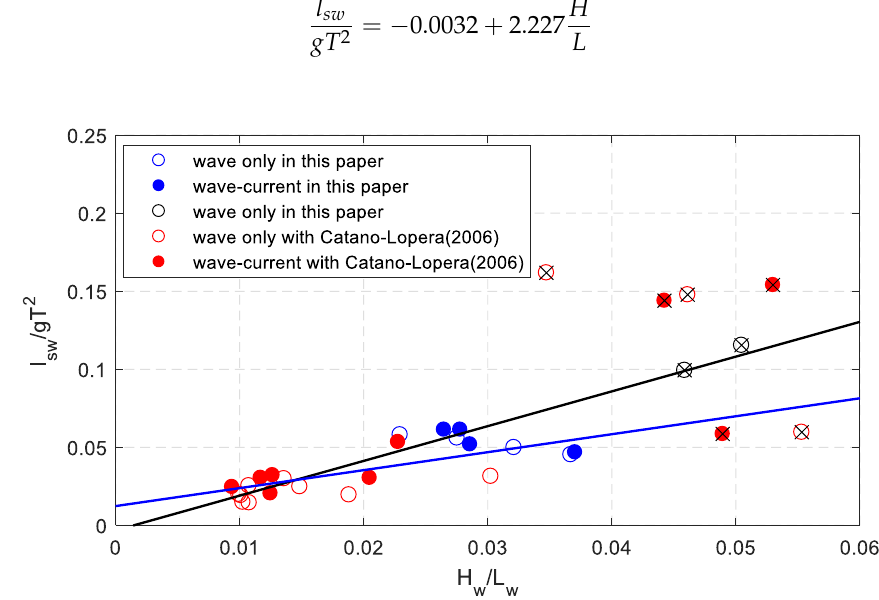
Figure 11. The relationship between the measured dimensionless sand wave height and dimensionless wave length.